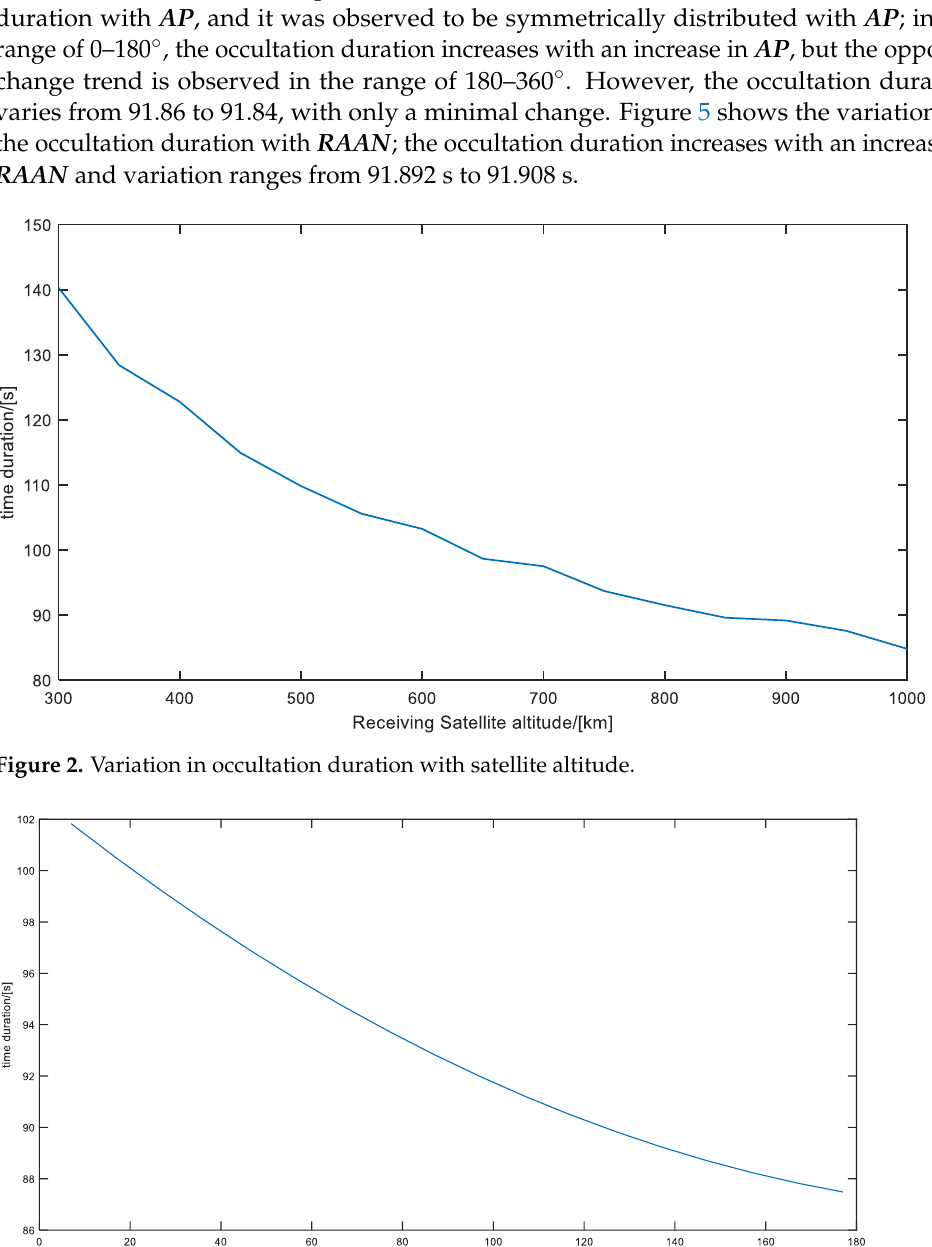
Figure 4. Variation in occultation duration with AP . Figure 5. Variation in occultation duration with RAAN . 3.3. Influence of Orbital Elements on the Longitudinal and Latitudinal Distribution of Occulta- tion Events According to the parameter settings in Table 1, the effects of satellite orbit altitude, inclination, AP , and RAAN on the longitudinal and latitudinal distribution of stellar oc- cultation events were studied. As shown in Figure 6, H was used to analyze the number and distribution of occultation events that occurred at 300 km and 900 km, and the orbital altitude was found to have no effect on the latitudinal range covered by the occultation